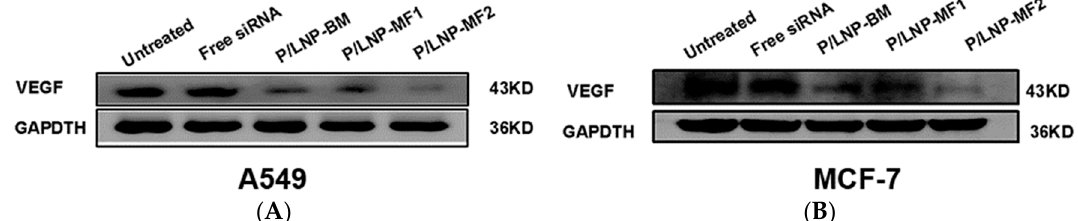
Figure 6. The expression of vascular endothelial cell growth factor (VEGF) in protein levels evaluated by Western blot. ( A ) A549 cells; ( B ) MFC-7 cells.